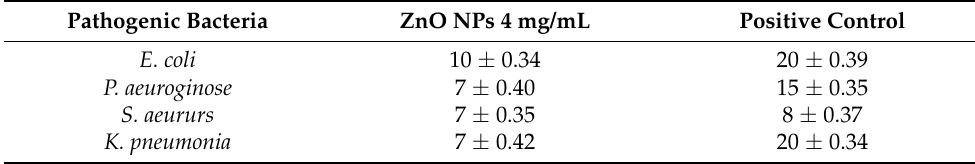
Table 3. Antibacterial Activity of The Mycosynthesized Zinc Oxide